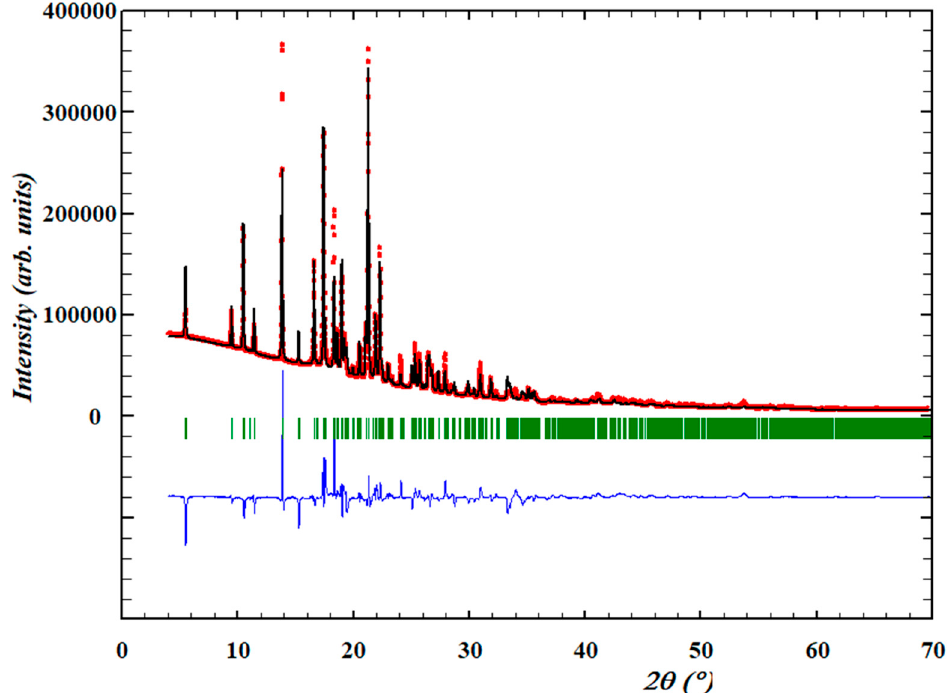
Figure 6. Rietveld plot for the structure from step 11 of zonisamide/ ϵ -caprolactam cocrystal obtained by DFT-D. The plot shows the experimental powder XRD profile (red marks), the calculated powder XRD profile (black solid line), the difference profile (blue, lower line) and Bragg positions (green lines). Agreement factors: R wp = 9.66%, R p = 5.62%. Enlargement from 8 to 22° in 2 θ is also represented.